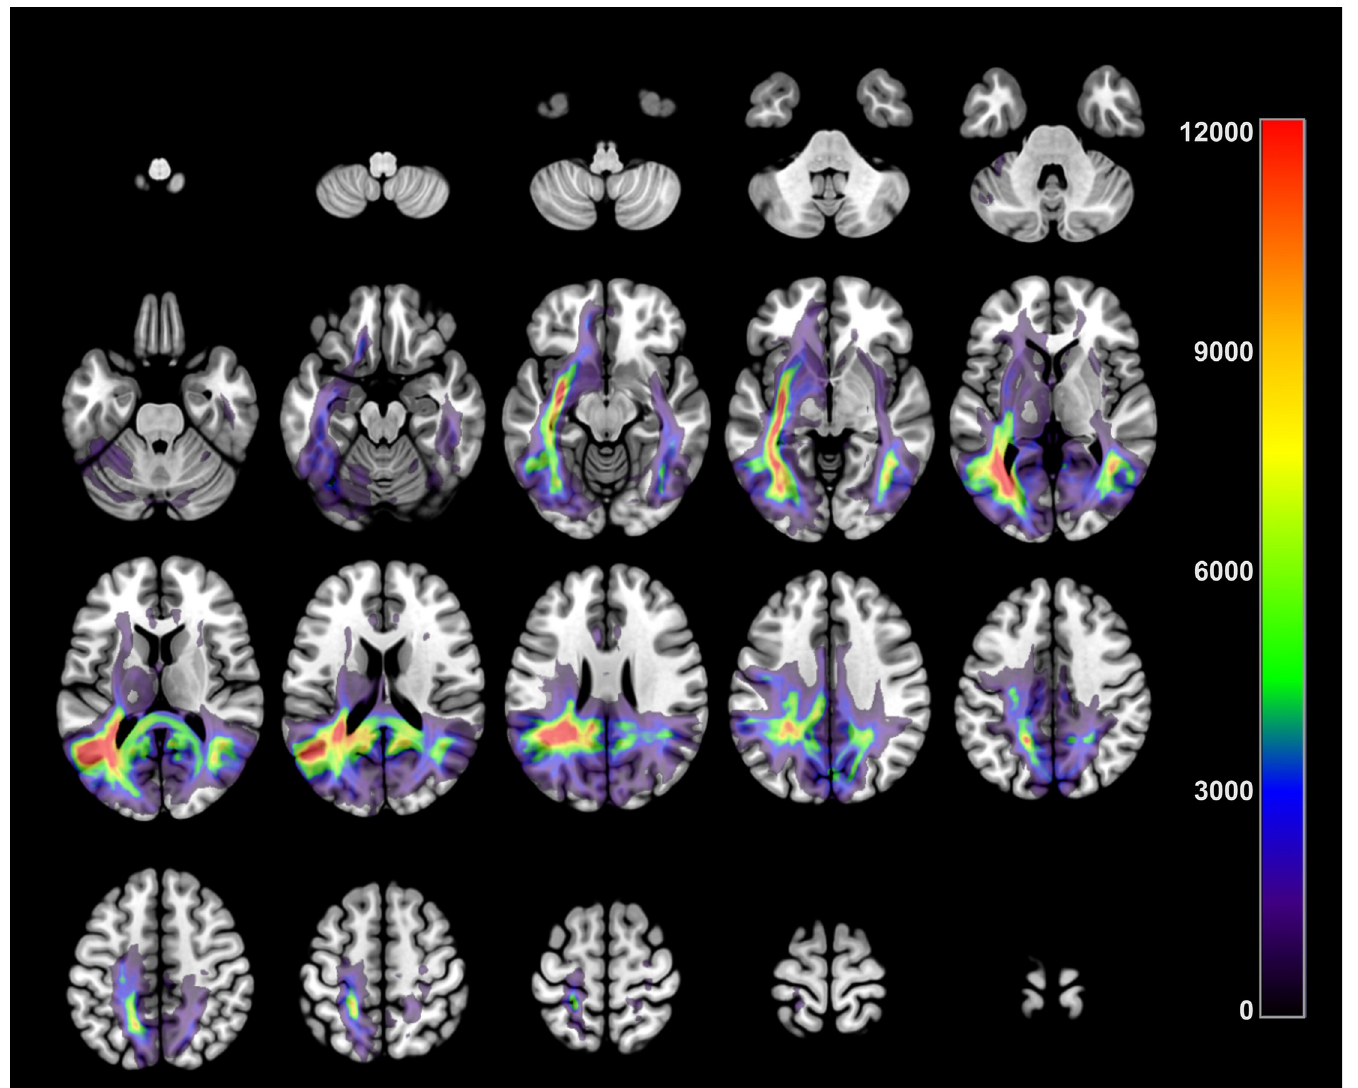
Fig 3. Connectivity path among the functional seeds obtained using probabilistic tractography. The average of count of visits is drawn in each voxel. Color indicates the number of visits.